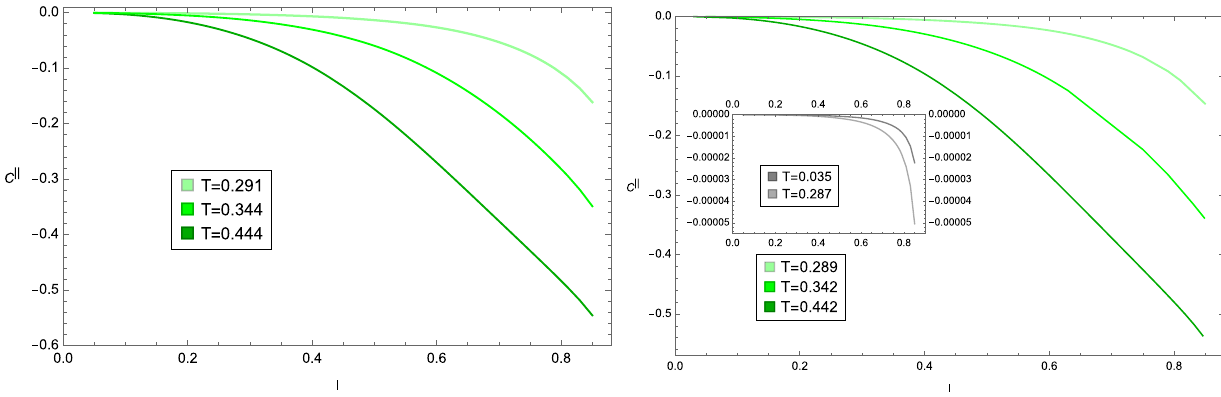
Fig. 8 Left: C || as a function of l at ν = 2 and μ = 0 for temperatures above and near T HP ≈ 0 . 290. Right: C || as a function of l at ν = 2 for μ = 0 . 05 and different values of temperature below and above the phase transition temperature, T